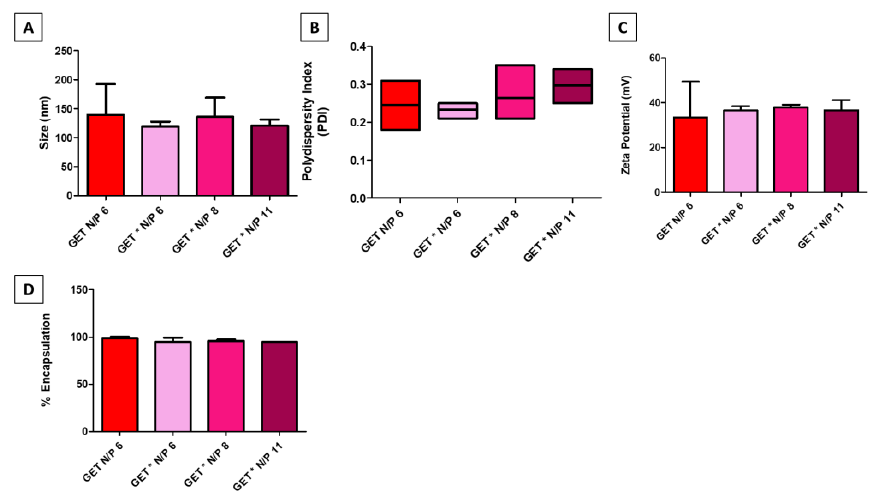
Figure 2. Physico-chemical characterisation demonstrated that there were no significant differences in ( A ) size (nm), ( B ) polydispersity index, ( C ) zeta potential (mV) and ( D ) % encapsulation efficiency between GET and modified GET* nanoparticles. Error bars represent ± SD, n = 3 samples tested in triplicate.